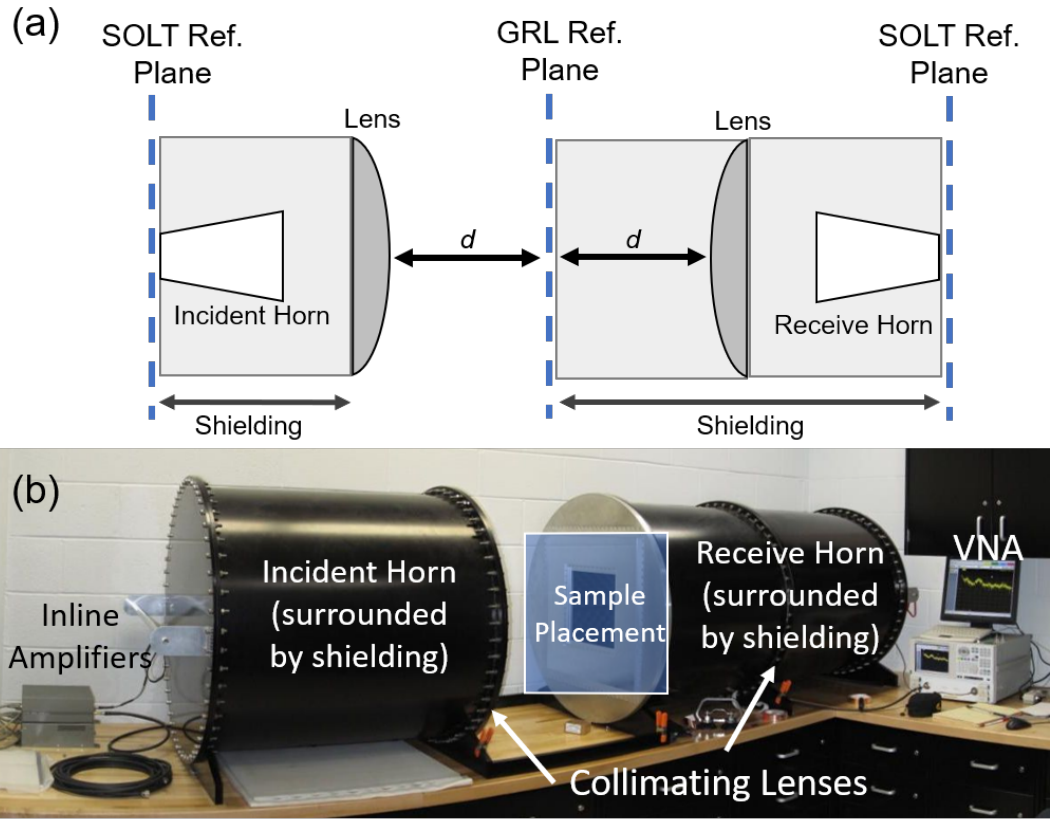
Figure 8. Experimental setup utilizing free-space testing and gated-reflect-line (GRL) calibration. ( a ) Schematic of FSS test setup denoting horns, the short-open-load-thru (SOLT) calibration planes and the GRL plane. ( b ) Image of experimental setup, highlighting the horn shielding